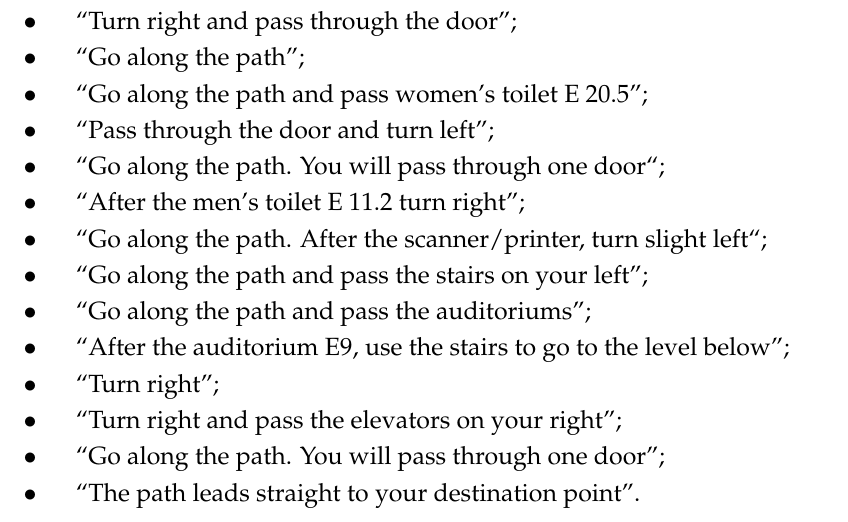
Figure 16. Axonometric-based landmarks. 4. User Study To investigate the feasibility of the ILNM, a user study was designed. The study consisted of the following three discrete components: i. A pilot study; ii. Wayfinding experiment with 30 participants; iii. Results interpretation. 4.1. Pilot Study In order to resolve basic issues of the system already before the actual experiment, a pilot study was conducted, with a usability expert testing the system and providing feedback. The main points of his feedback were the following: •